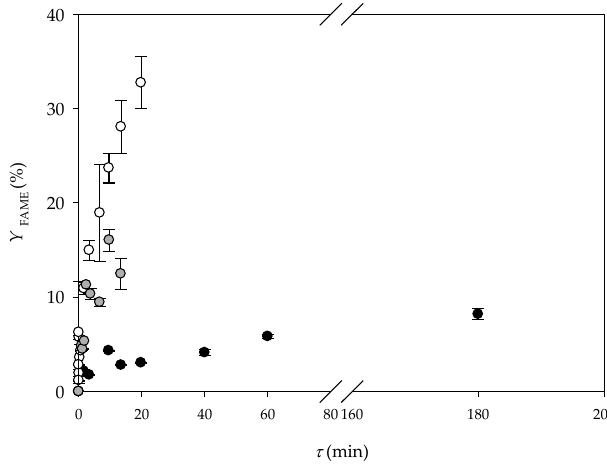
Figure 3. Lipase catalysed biodiesel synthesis in a glass microreactor with ( a ) two inlets ( ● ), and ( b ) three inlets ( ○ ) and a polytetrafluoroethylene (PTFE) microreactor with tree inlets ( ● ).